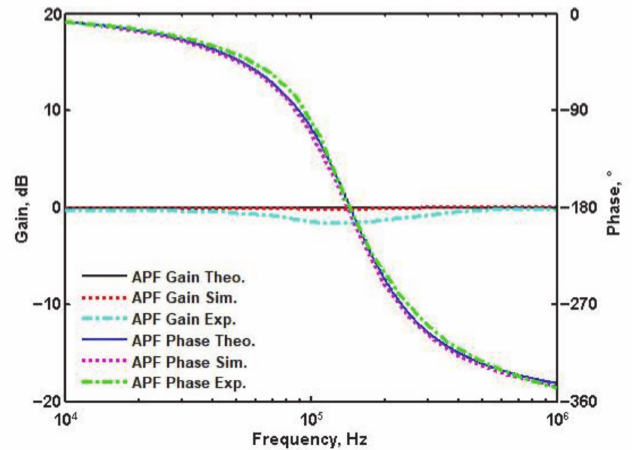
Figure 13. Comparison of APF experimental response, simulated response, and theoretical response in Part